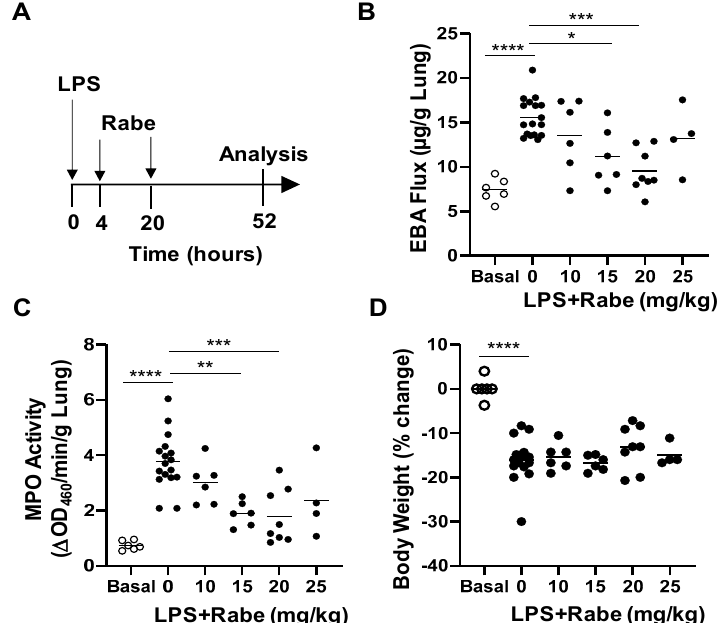
Figure 2. Rabeprazole reduces lung vascular permeability and neutrophil sequestration in a dose- dependent manner at 52 h post-LPS challenge. ( A ) Schematic representation of experimental design. WT mice received PBS vehicle (Basal) or LPS (2.5 mg/kg, i.p.). At 4 and 20 h post-LPS, mice were treated with either PBS vehicle (0 mg/kg) or indicated dose of Rabeprazole (Rabe, oral). Lung tissues were collected for analyses at 52 h post-LPS. ( B ) EBA flux assay showing dose-dependent reductions in lung vascular permeability resulting from oral Rabeprazole treatment. ( C ) Lung neutrophil sequestration as measured by MPO activity assay was reduced in Rabeprazole-treated LPS mice compared to vehicle-treated LPS mice. ( D ) Weight change in LPS-free basal mice and in LPS-challenged mice with or without Rabeprazole treatment. * p < 0.05, ** p < 0.01, *** p < 0.001, and **** p < 0.0001. One-way ANOVA with Bonferroni post-tests.